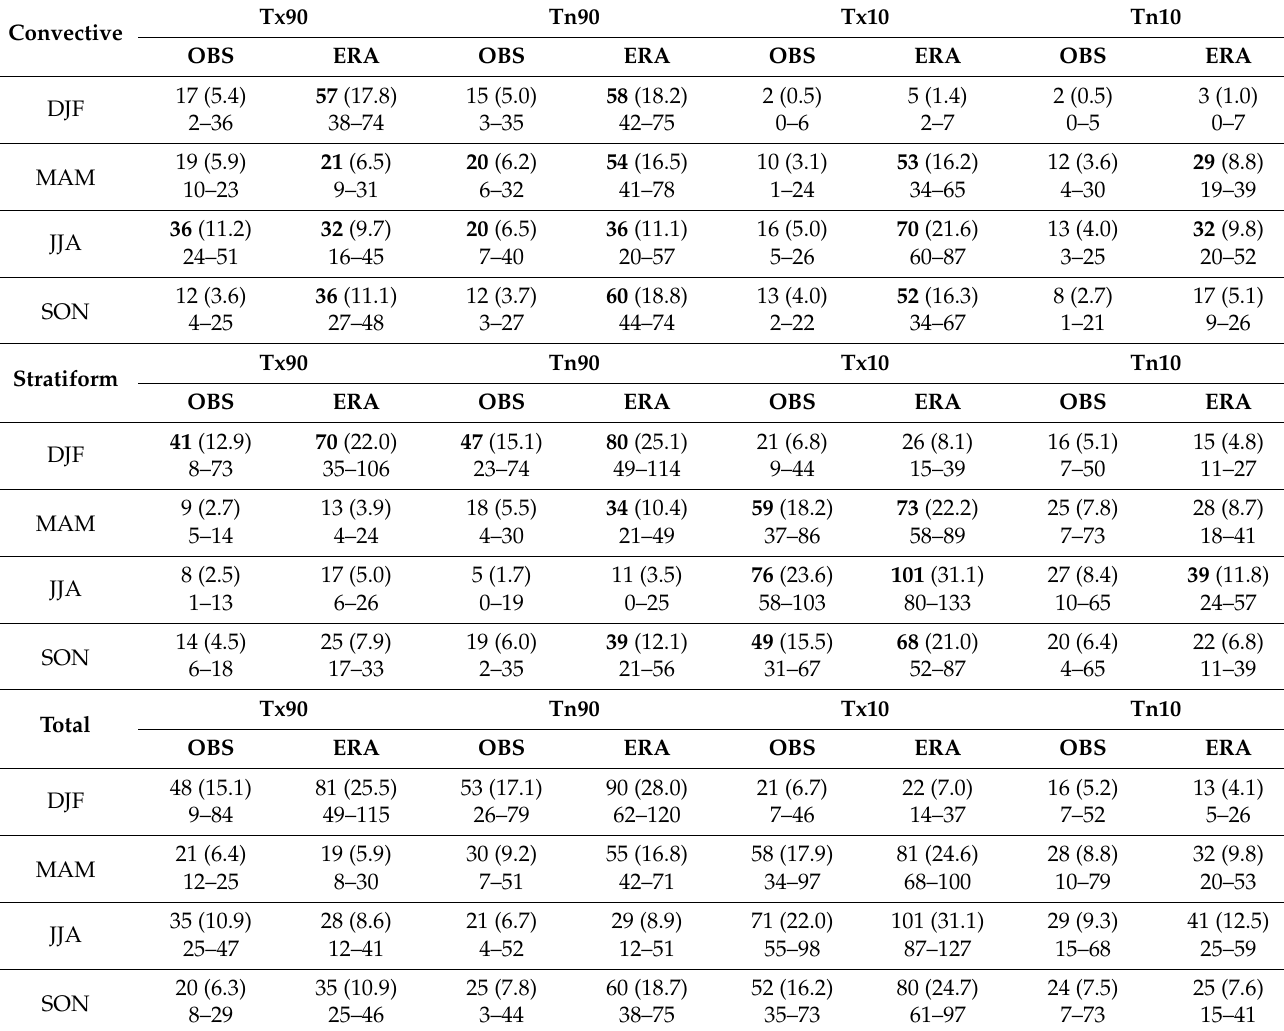
Table 4. Frequency of compound events (days per season). Means and ranges (second line) for the 11 stations (OBS) or the 33 grid boxes of ERA-Interim (ERA) for the period 1982–2016. Mean percentage of days with compound events over the total extreme-temperature days per season is given in parentheses. Compound events with a mean frequency greater than 30 days for stratiform (20 days for convective) precipitation are denoted in